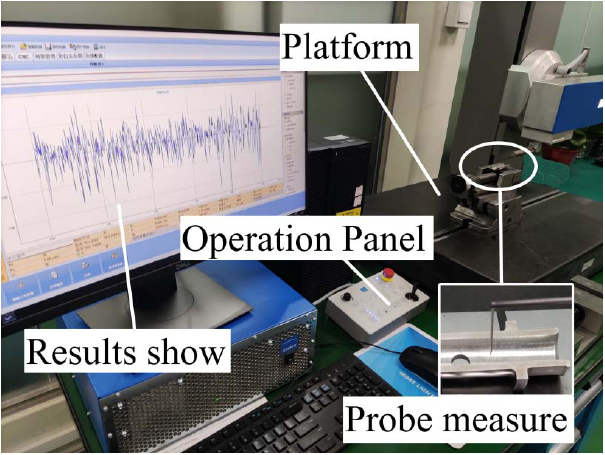
Figure 3. Roughness profilometer.